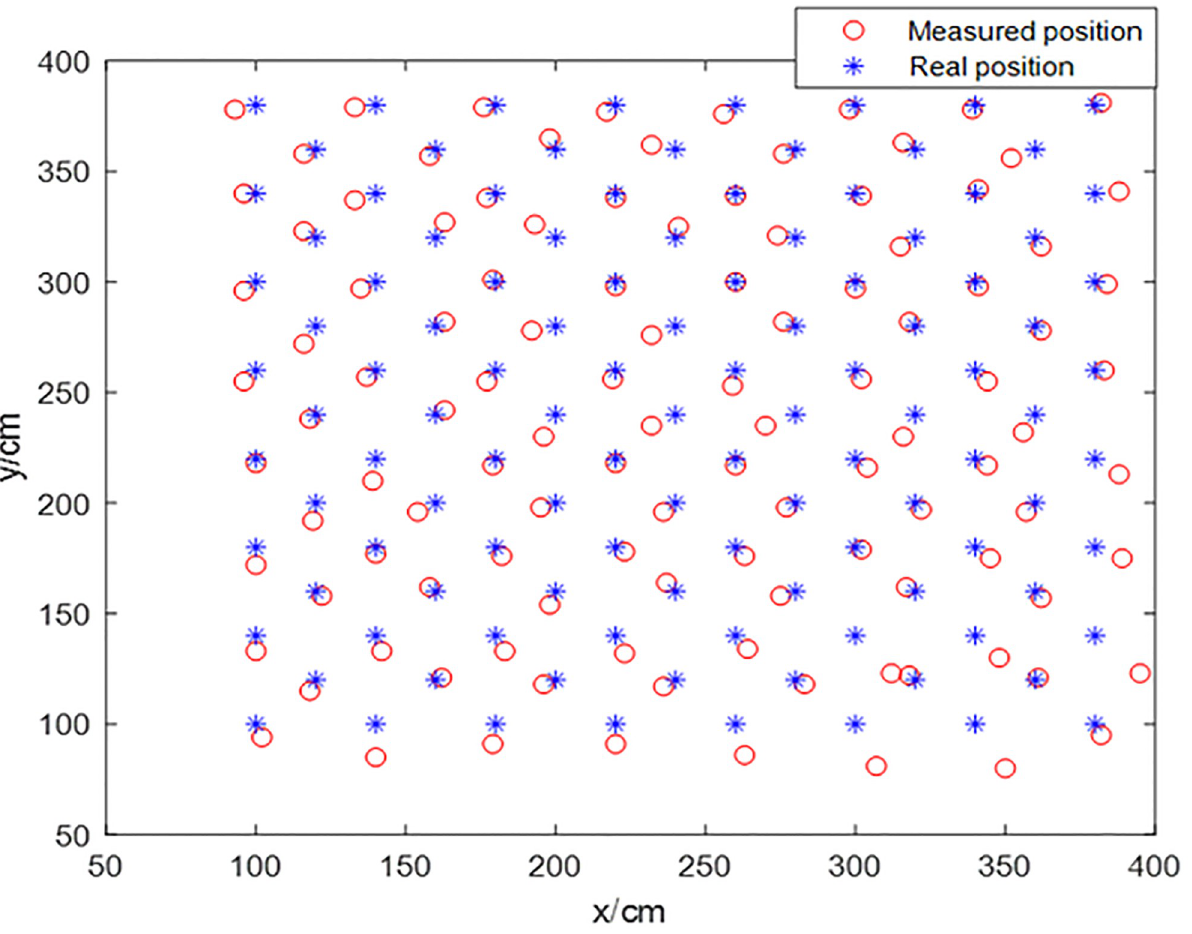
Fig 9. Measured positions and real